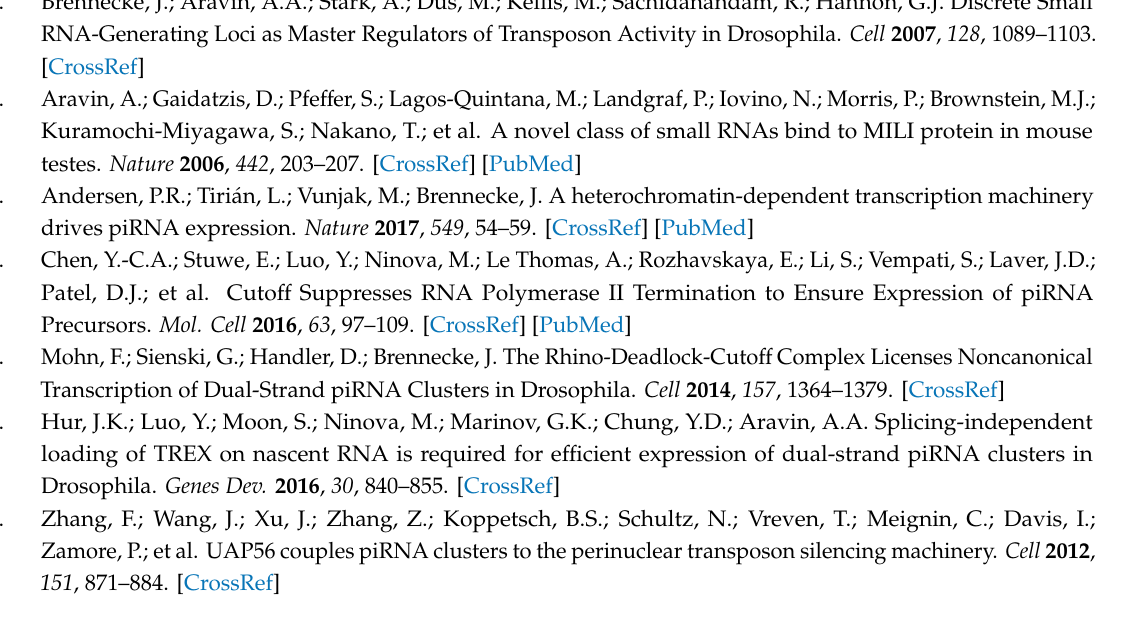
Figure S1: (Related to Figure 3) The levels of I -specific piRNAs in the transgenic strains. The scatter plots show normalized TE-specific piRNAs (24–29 nt reads were considered, 0 or 0–3 mismatches allowed) in the ovaries of the indicated transgenic strains at the R and I background. Table S1: Genomic coordinates and orientation of I-TG transgene insertions. Table S2: A test of the inducer phenotype of transgenic strains at the I background. Table S3: Transgenic small RNA content at di ff erent genetic backgrounds (0 mismatches). Table S4: Transgenic small RNA content at di ff erent genetic backgrounds (1-3 mismatches). Table S5: Primers used in the study (5’ to